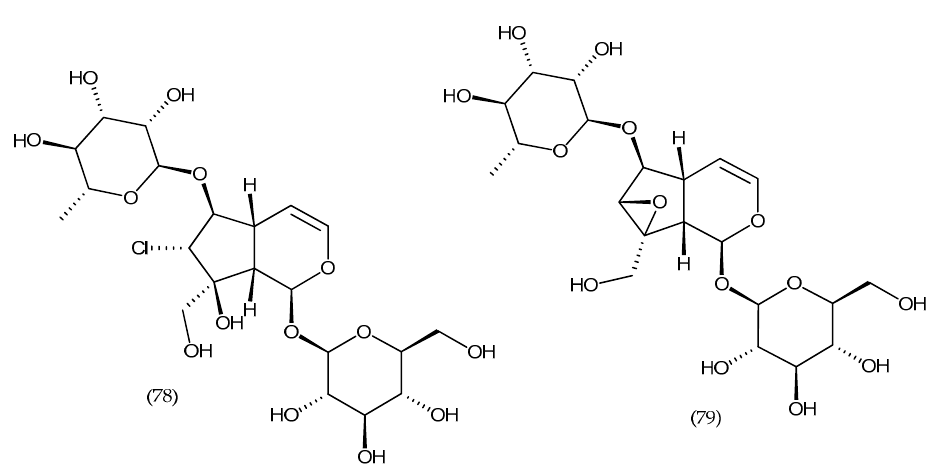
Figure 13. Structures of isolated compounds catarractoside and 6- O -rhamnopyranosylcatalpol (species Veronica derwentiana and Veronica catarractae ).